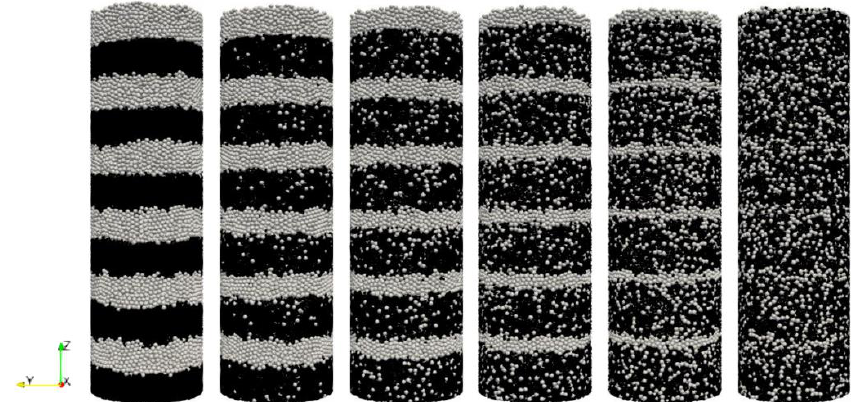
Figure 13. Stock column structures with different coke mixing ratios (gray: coke; black: sinter).